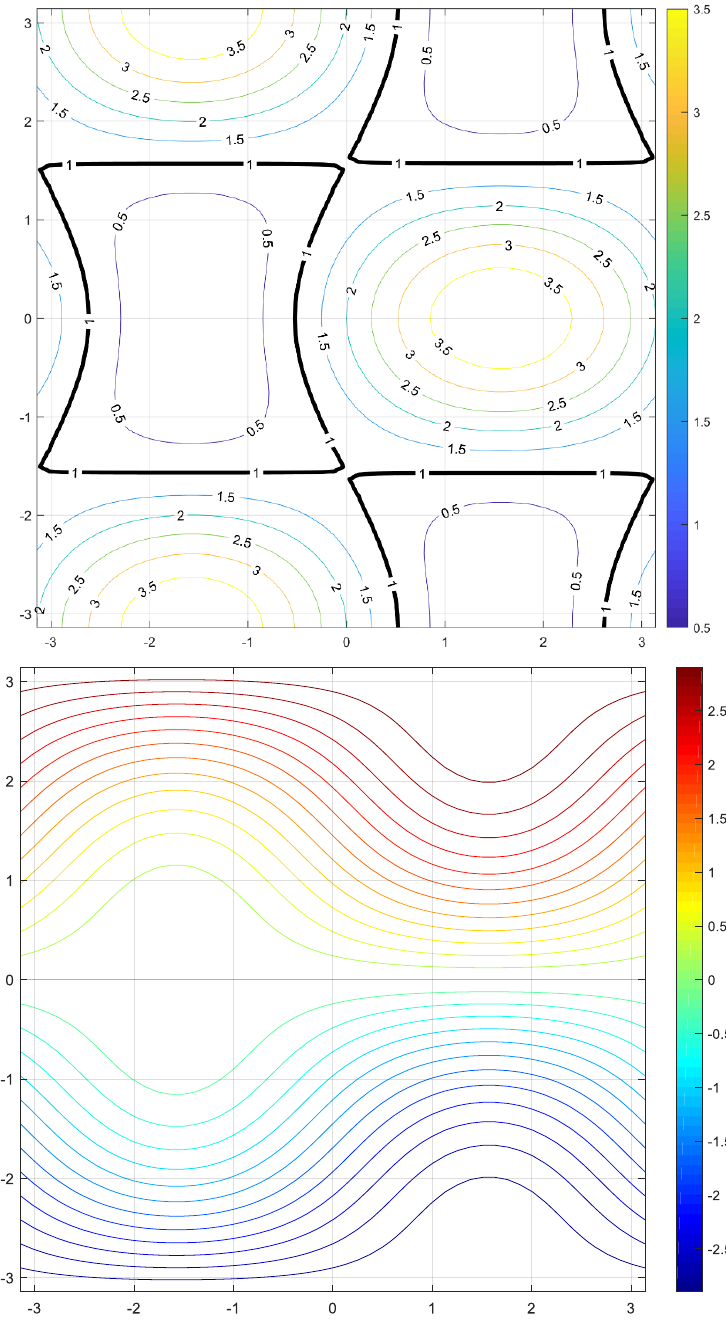
Figure 4. Illustration of the 2D periodic flow problem of Philip [70] for 𝑎 = 1 , in a square domain [−𝜋,+𝜋] × [−𝜋,+𝜋] . Top: Permeability contours 𝑘(𝑥,𝑦) . Bottom: streamlines obtained as iso-values of the stream function 𝜓(𝑥,𝑦) .